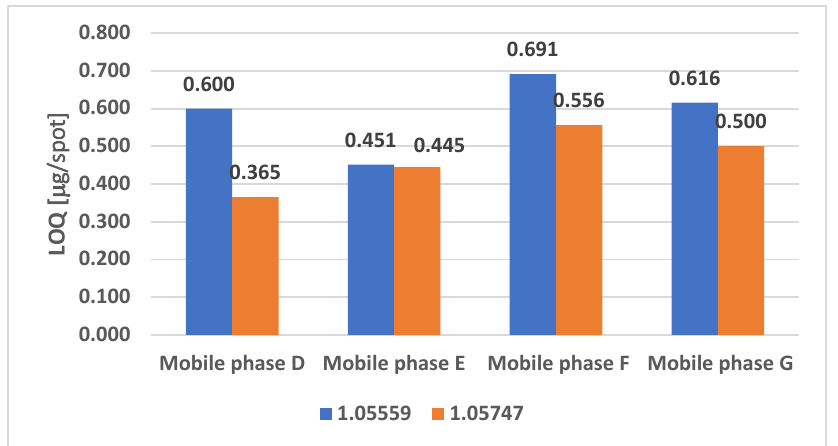
Figure 5. Mean values of the limit of quantification of fluoxetine, obtained by partition thin-layer